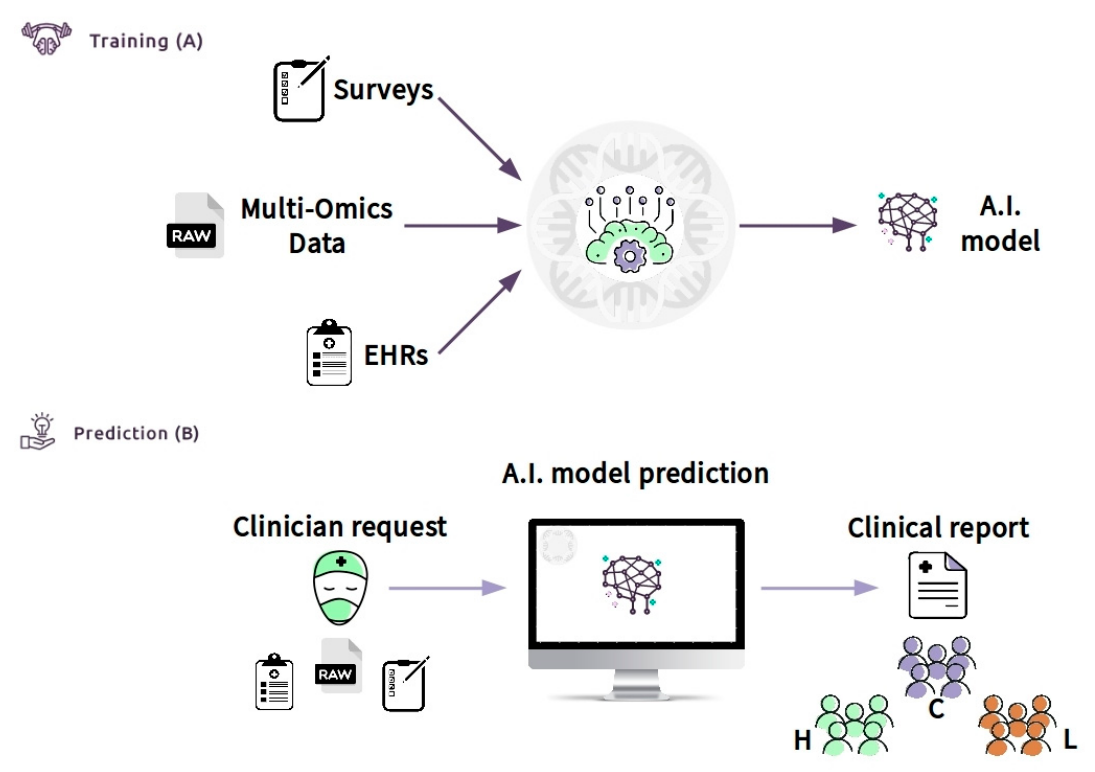
Figure 6. Clinical decision support system (CDSS) as a new approach to ASD children to screen and improve the age of diagnosis: Box ( A ) (training) shows the flowchart including all data used (survey, such as Child Health Improvement through Computer Automation system (CHICA), omics data and electronic medical records (EHR)) by machine learning model to classify patients. Once the model has been constructed with good accuracy, the clinician (box ( B )) (prediction) will upload the patient data. An A.I. model will predict the class with an actionable result summarized in the clinical report. The result will generate subgroups based on the patient’s features, for example, high functioning (H), low functioning (L), and control group (C). This system might be used by clinicians to improve early diagnosis because it provides significant information about the features of the ASD patient.